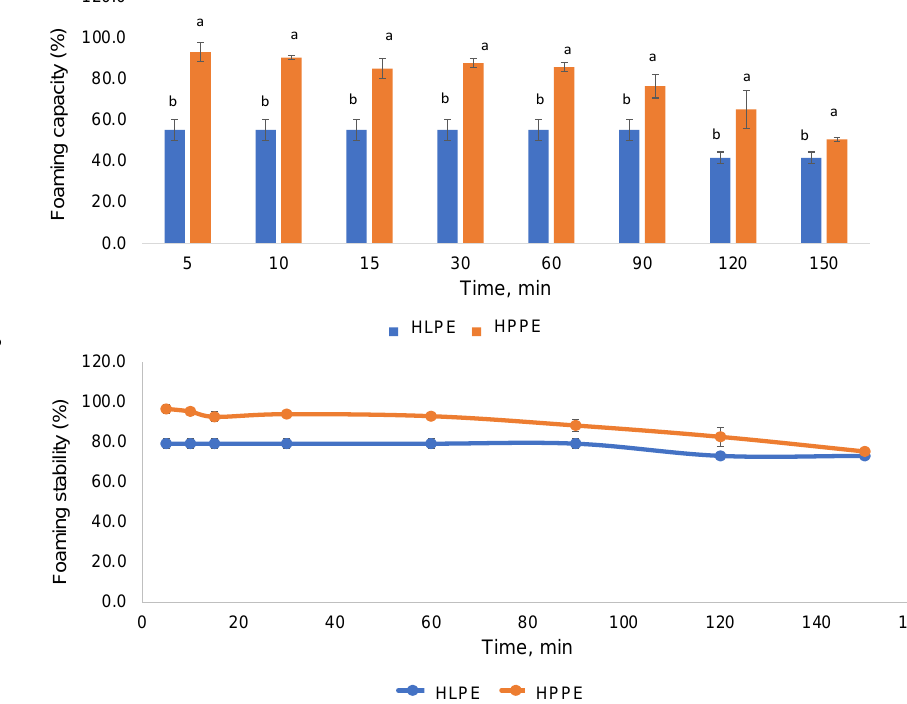
Figure 6. The foaming capacity ( A ), for each time point, means with different superscripts (a,b) are significantly different ( p < 0.05), as determined by the post hoc Tukey’s honestly significant difference (HSD) test, and foam stability ( B ) of the Huhu larvae and pupae protein extracts at different time points.